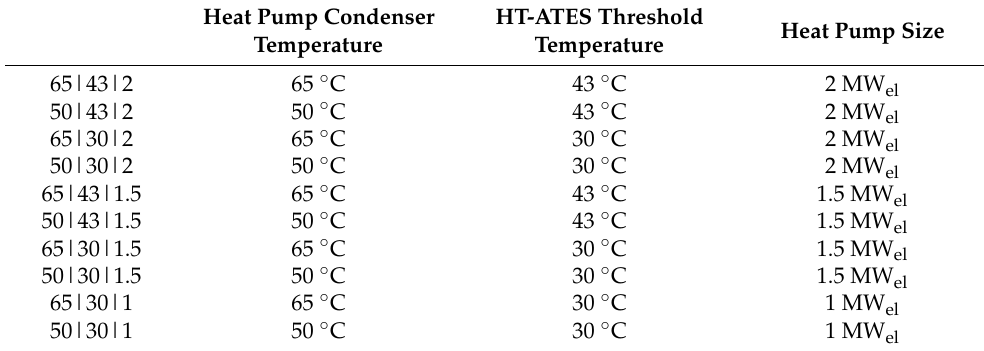
Table 3. Overview of